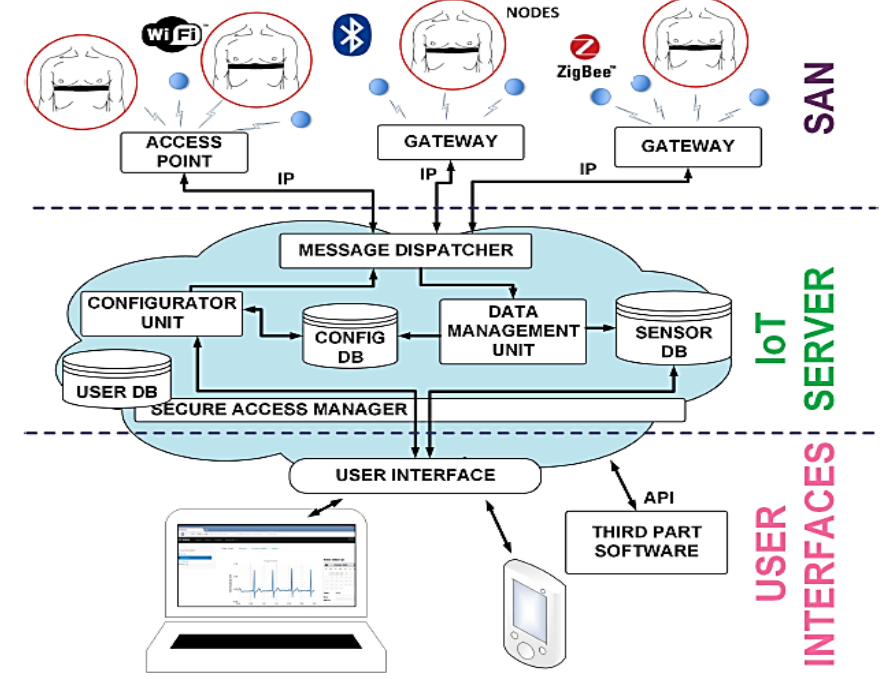
Figure 22. Block diagram of the IoT platform supporting the in-home Smart Grid [70] (Reprinted with permission from ref. [70]. Copyright 2021 IEEE).